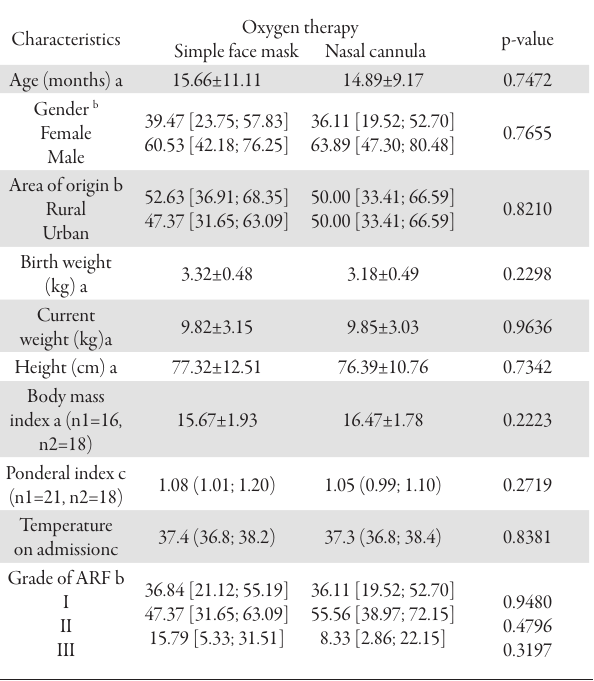
Tab. 2. General characteristics of subjects with acute respiratory